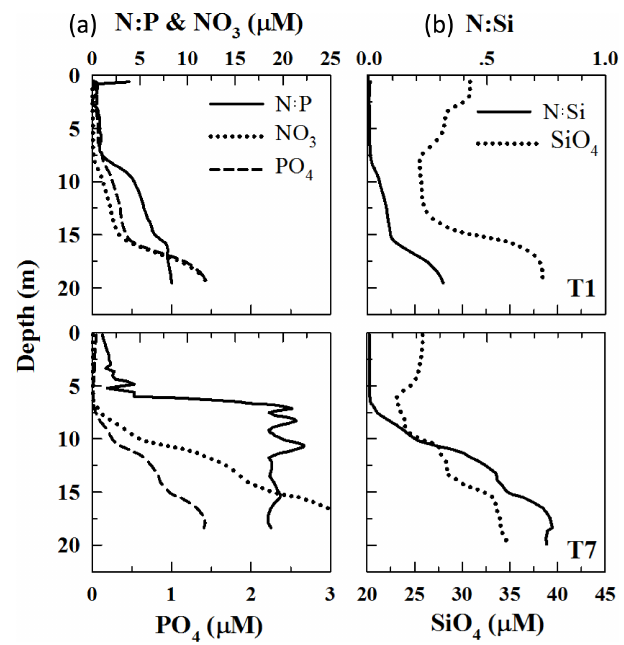
Figure 3. Two vertical profiles (T1 = 12:15 and T7 = 06:15UTC) in the time series for 6–7 August 1991 of nutrients at S3. (a) NO − PO 3 − and N:P ratios. (b) SiO − 4